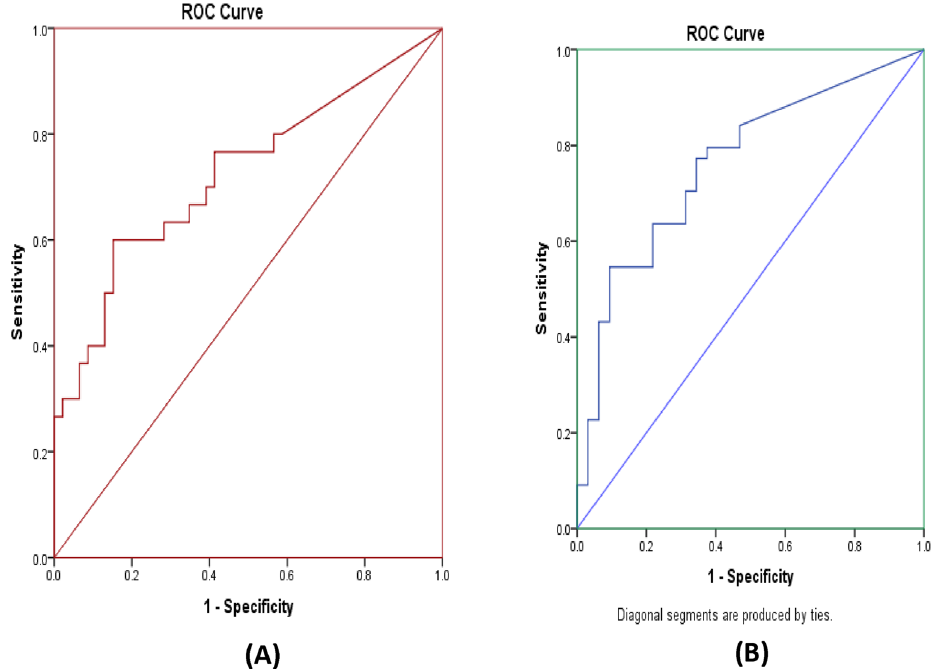
Figure 6. Receiver operating curve analysis to determine the trade-off parasite load of PKDL cases for being diagnosed as positive in Microscopy ( A —left) and B&S-LAMP Assay ( B